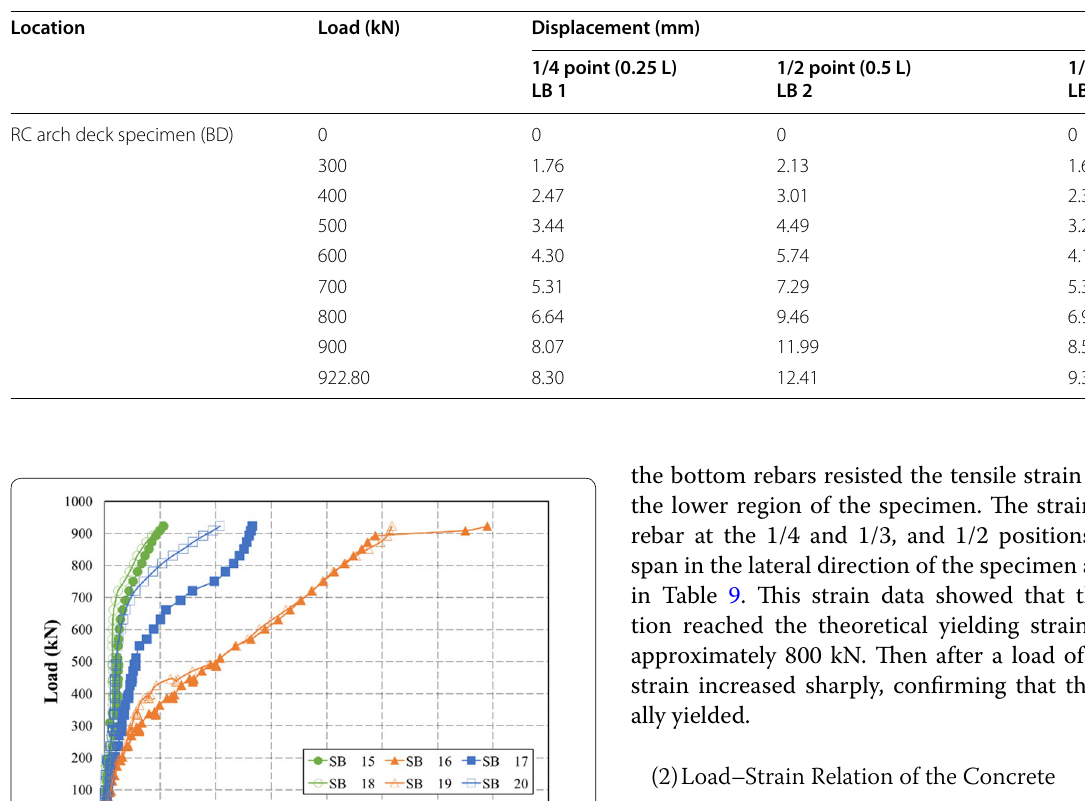
Table 8 Test results of load–displacement (BD).